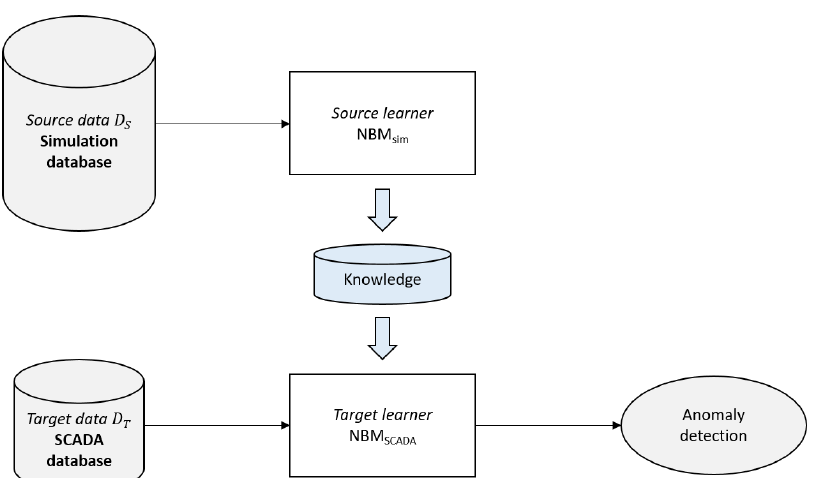
Figure 1. Schematic illustration of knowledge transfer for monitoring wind turbines using simulations and measured SCADA